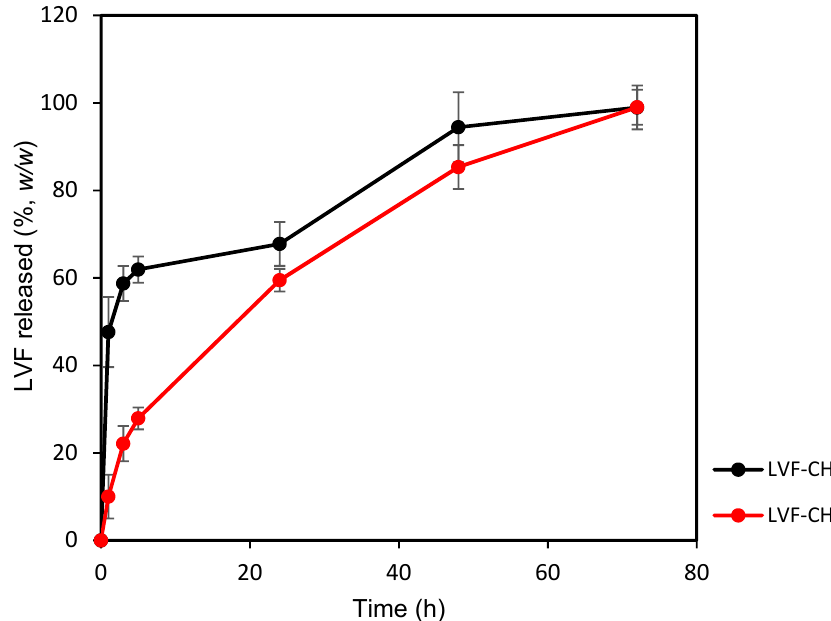
Figure 7. Release profile (%) of LVF–CH/TPP 3 NPs and LVF–CH/SBE- β -CD 3 NPs, as a function of time. Experiments were carried out using dynamic diffusion Franz cells and a synthetic membrane, and the results are expressed as mean values of three different experiments from three different batches ± standard deviation.